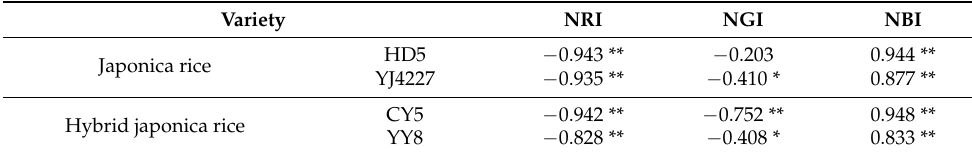
Table 8. Correlation coefficients between SPAD and the color indices of rice leaves after